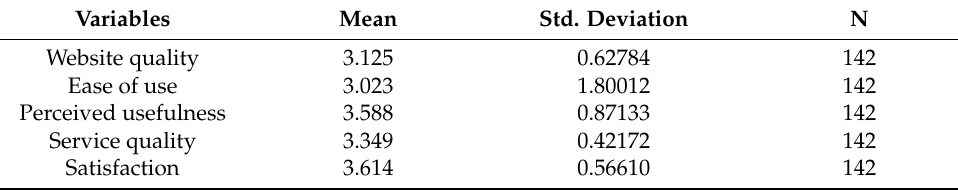
Table 8. Descriptive statistics of the